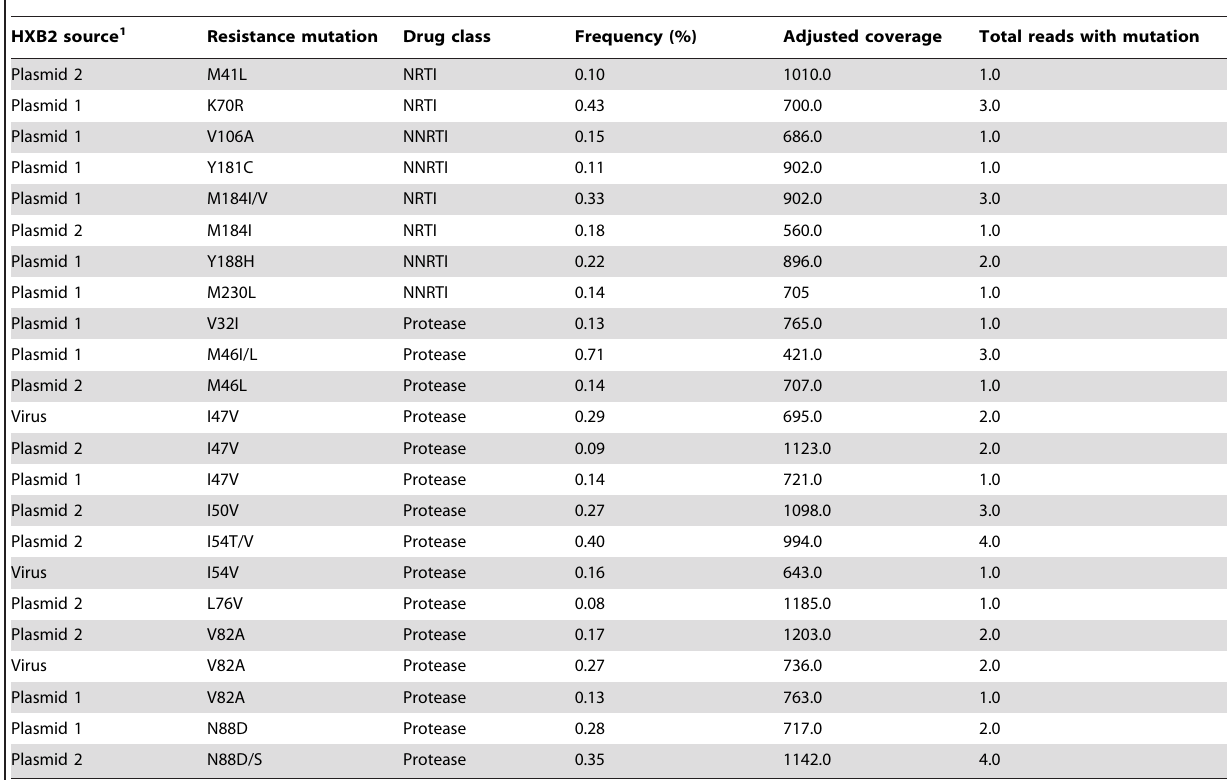
Table 1. ‘‘False’’ drug resistance mutations found in the HXB2 plasmid or HXB2 viral stock.